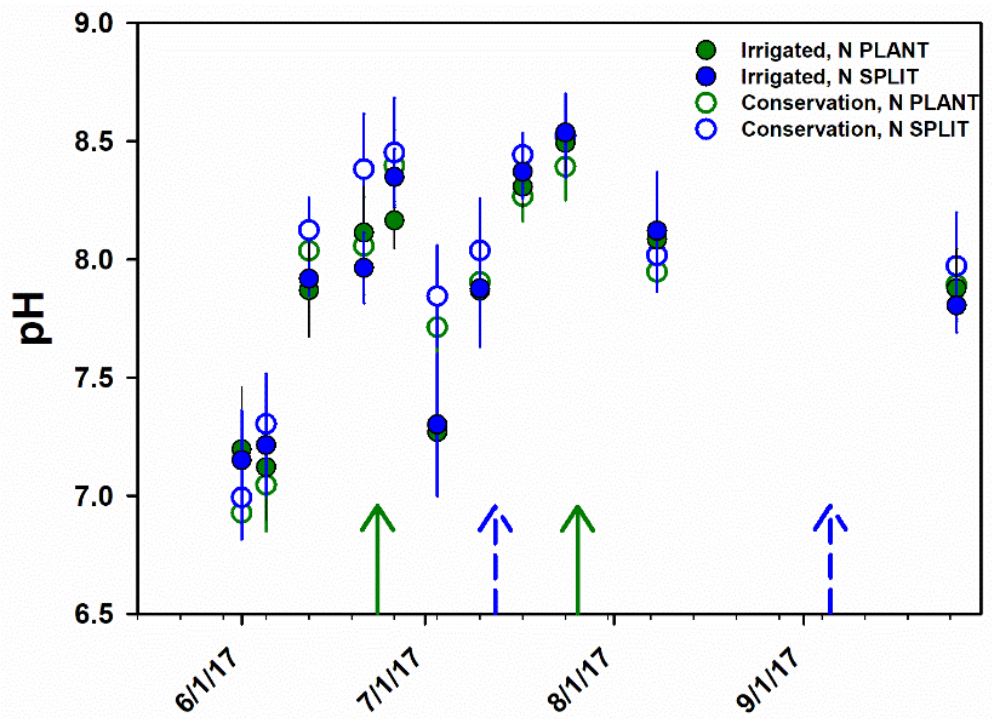
Figure 5. Soil pH in sorghum fields under 30% less irrigation and full irrigation. Closed symbols indicate fertilizer additions entirely at planting; open circles denote N fertilization split between 2 applications. Values are mean pH ± SD. Up arrows indicate post planting irrigation events, green indicates irrigation only at “conservation” irrigation (2 time periods), blue arrows indicate additional irrigation fir “irrigated” treatment.